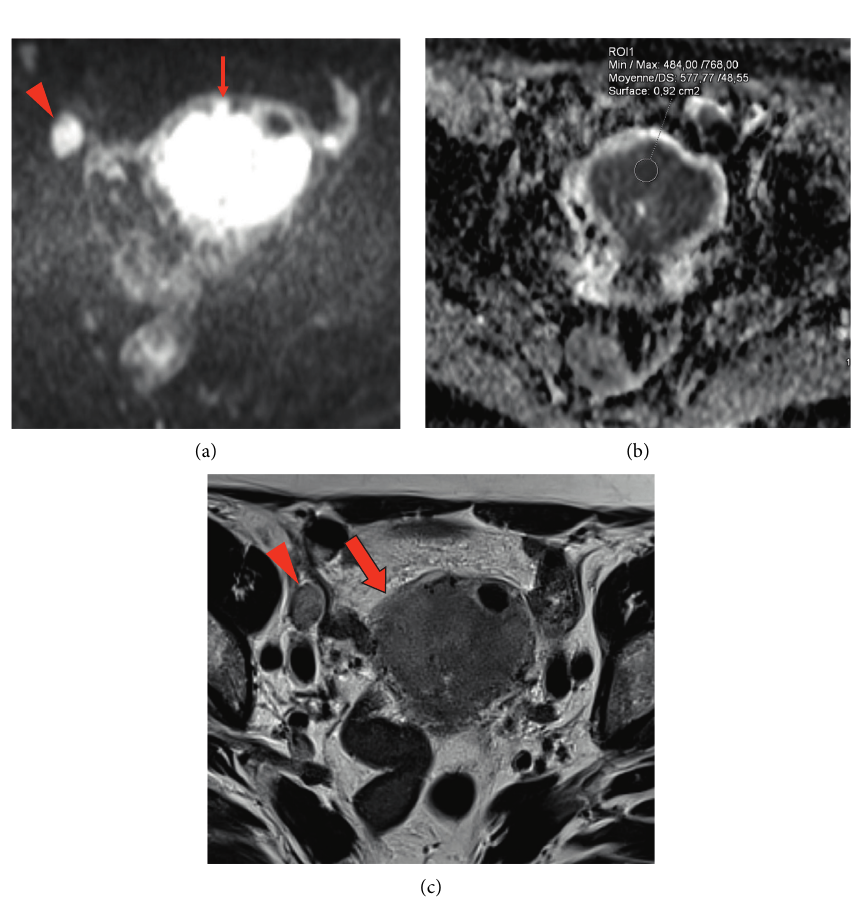
Figure 1: Pelvic MRI of endometrial stromal sarcoma: (a, b, c) axial DWI b1000 showing a large intrauterine tumor with high signal intensity and lobular/irregular tumor contours (arrow) (a) and low ADC value (0.58 × 10 − 3mm 2 /s) (b), and an obturator lymph node metastasis (arrowhead) (a). Note the intermediate T2 signal intensity of these two lesions and the blurred contours of the tumor (empty arrow)